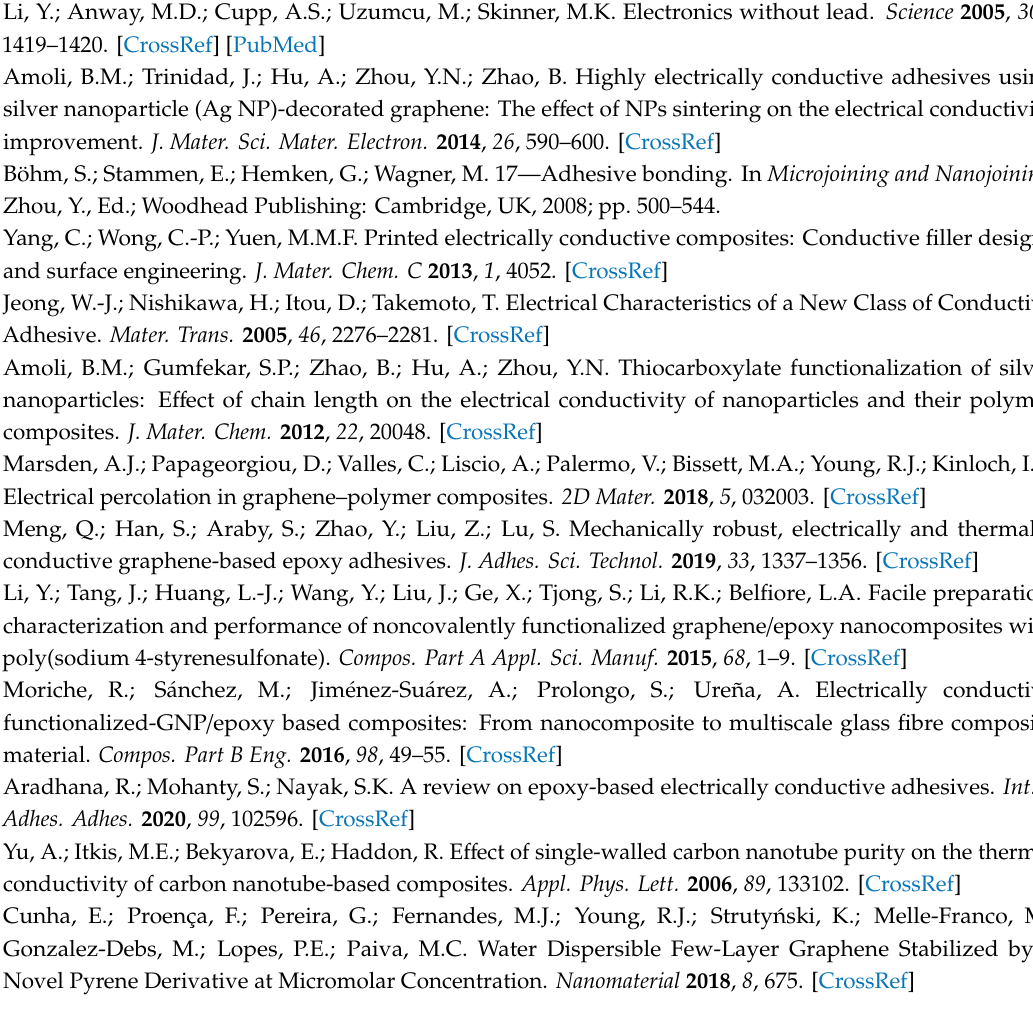
Figure S1. Stencil printing equipment used to deposit electrically conductive composits on the PCB’s; Figure S2. Transmission electron microscopy images of individual MWCNTs NC7000 and ropes of SWCNTs Tuball; Figure S3. Images of Raman intensity maps and typical Raman spectra; Figure S4. Schematic of the preparation of the samples for AFM analyze; Table S1. Settings used to operate the three-roll mill for the dispersion of nanomaterials in the epoxy resin; Table S2. Volume electrical resistivity for the composites prepared with epoxy CR141 and each carbon filler; Table S3. Thermal conductivity of the epoxy nanocomposites prepared with epoxy CR141 and SWCNT, EG and selected